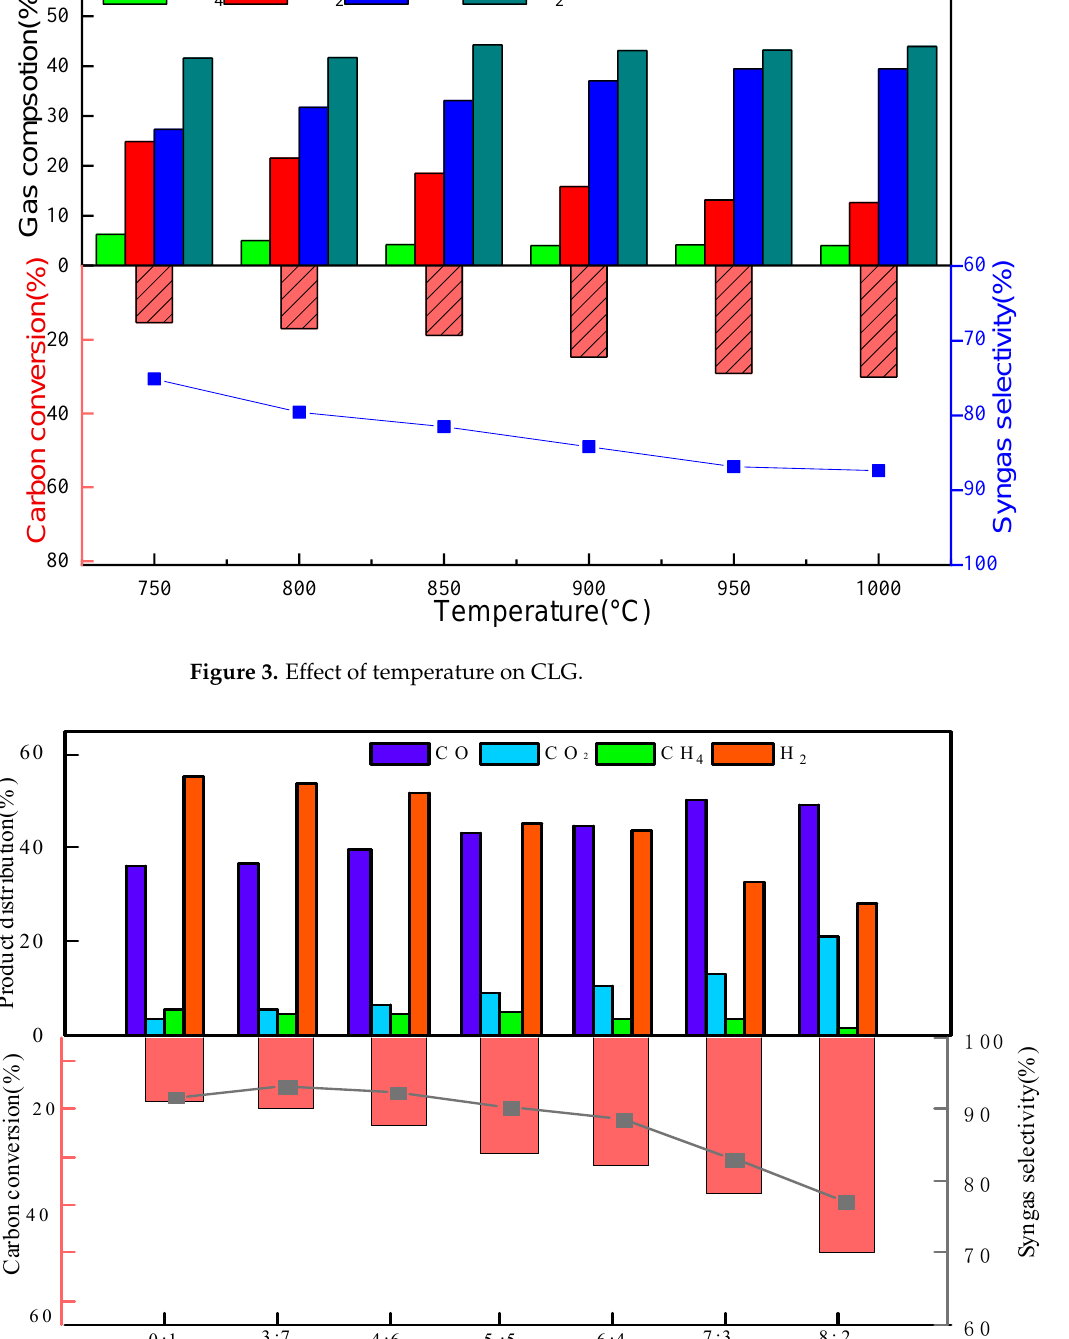
Figure 4. E ff ect of O/B ratio on CLG. Figure 4. Effect of O/B ratio on